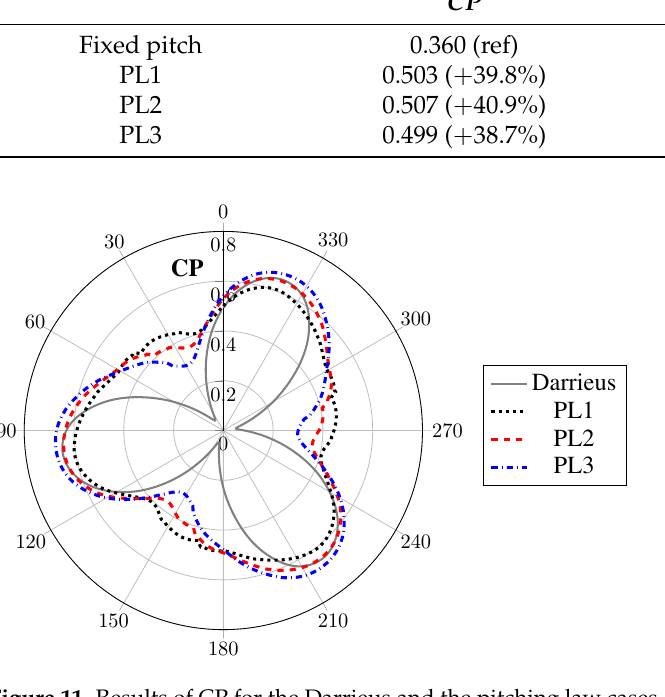
Figure 11. Results of CP for the Darrieus and the pitching law cases, λ =